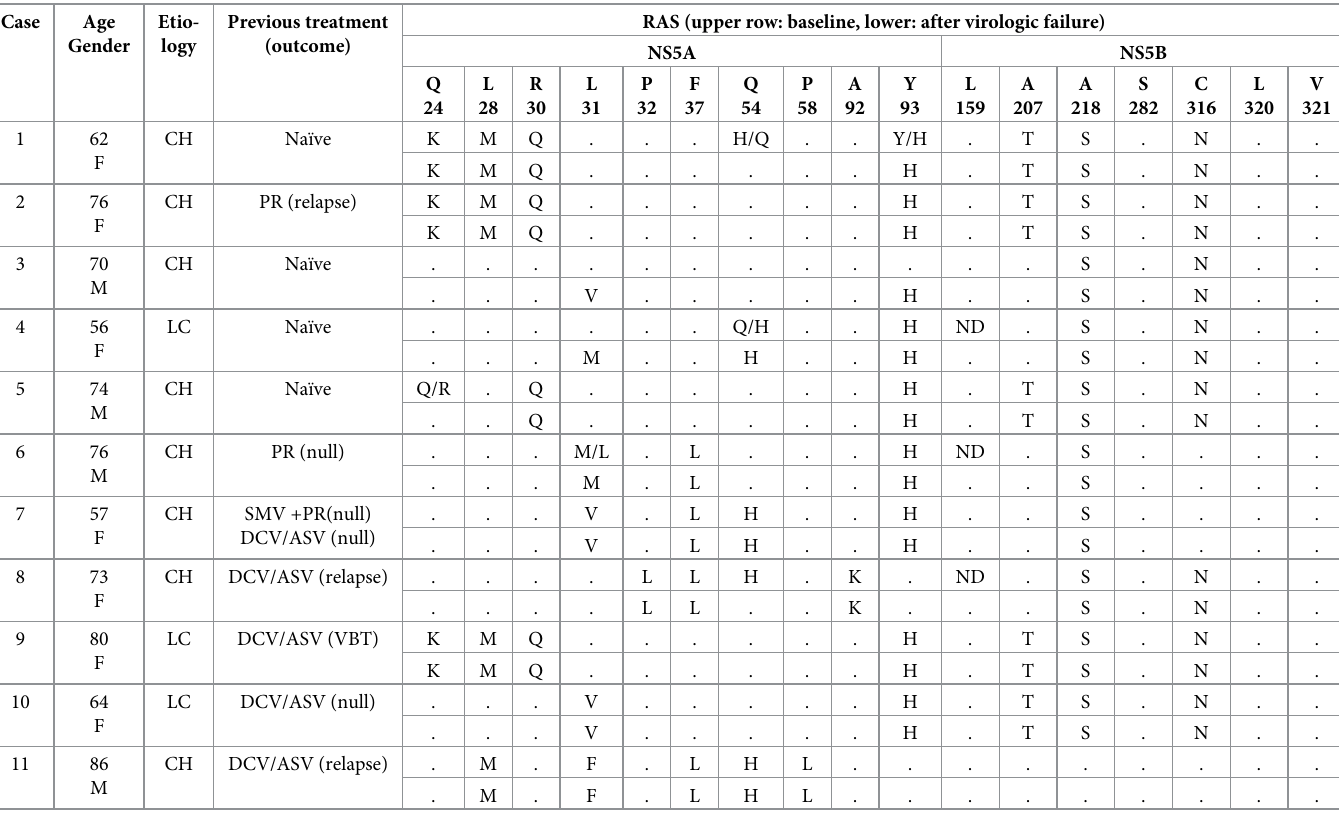
Table 2. The baseline resistance-associated substitutions (RASs) and virologic failure in patients treated with sofosbuvir and